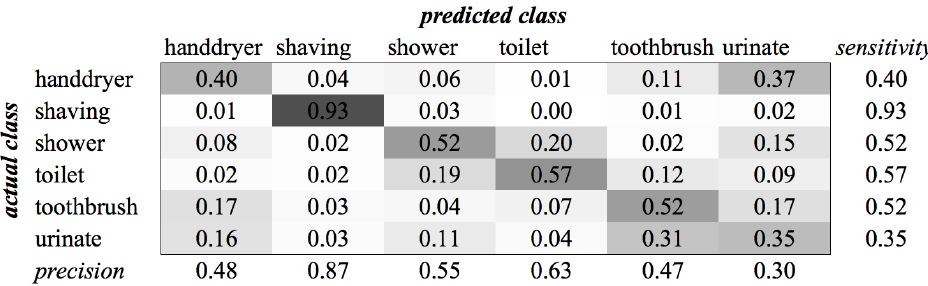
Figure A12. KHMM confusion matrix of category Bathroom for MFCC feature